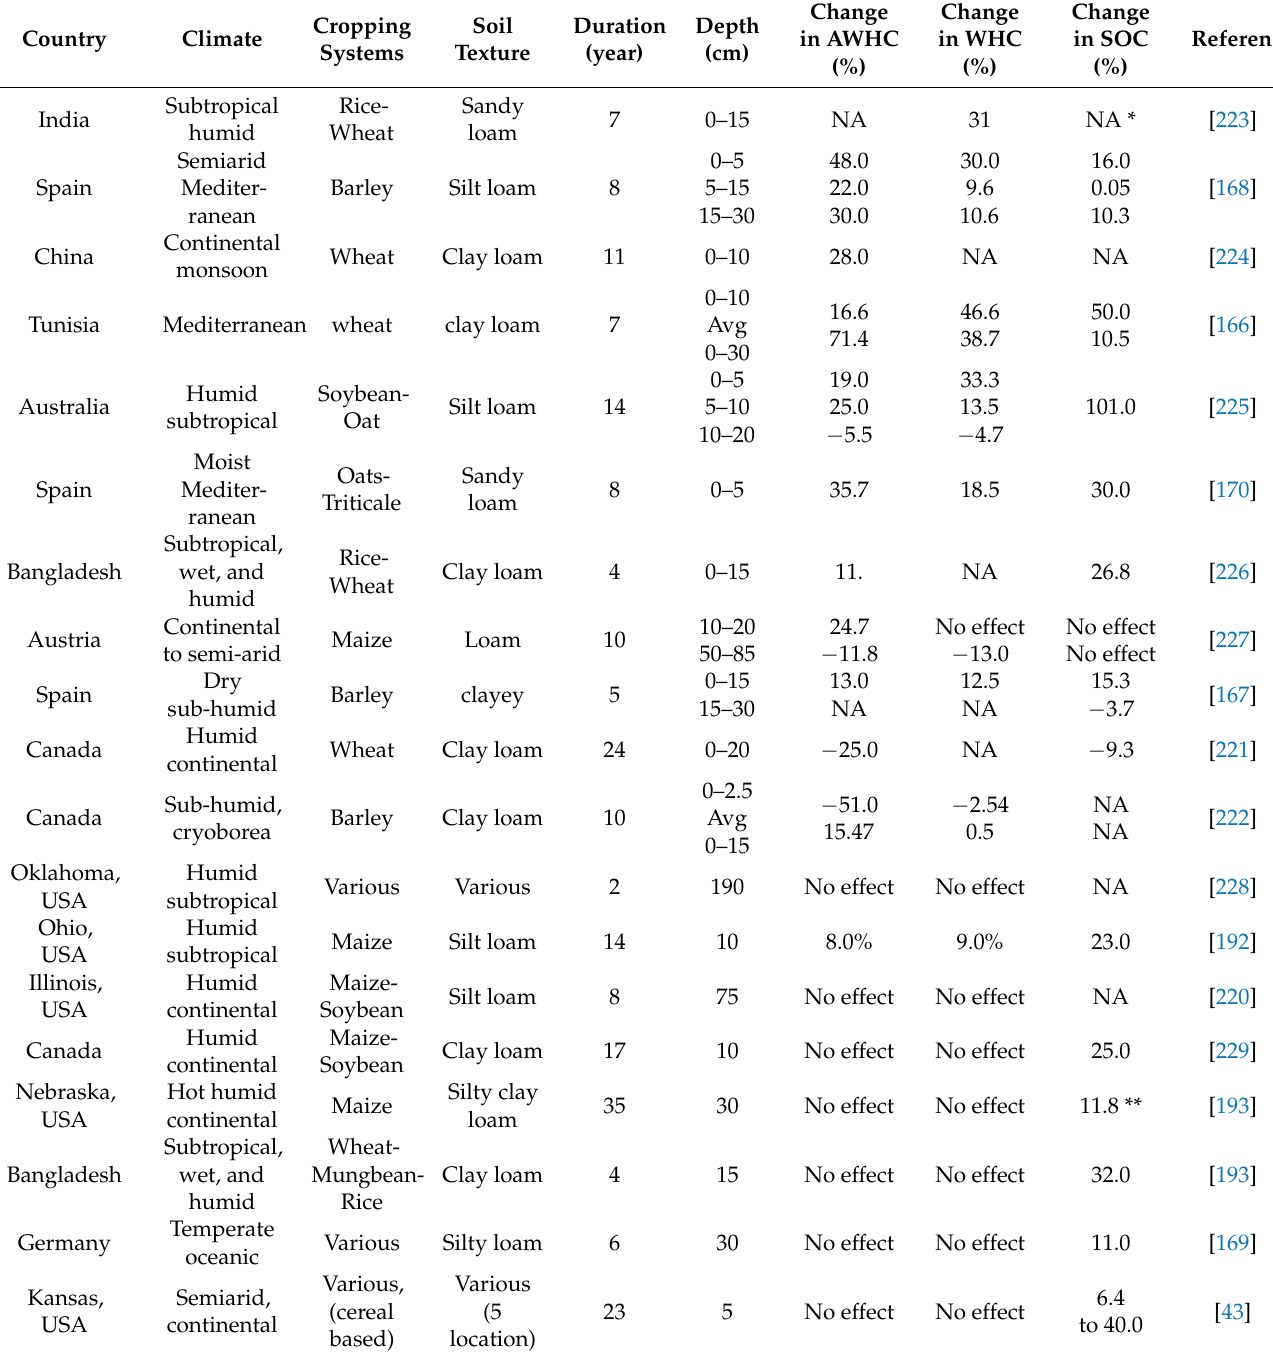
Table 2. Examples of water holding capacity (WHC) and available water capacity (AWHC) change following the adoption of conservation agriculture practices (zero or minimum tillage + crop residue retention, with or without crop rotation).